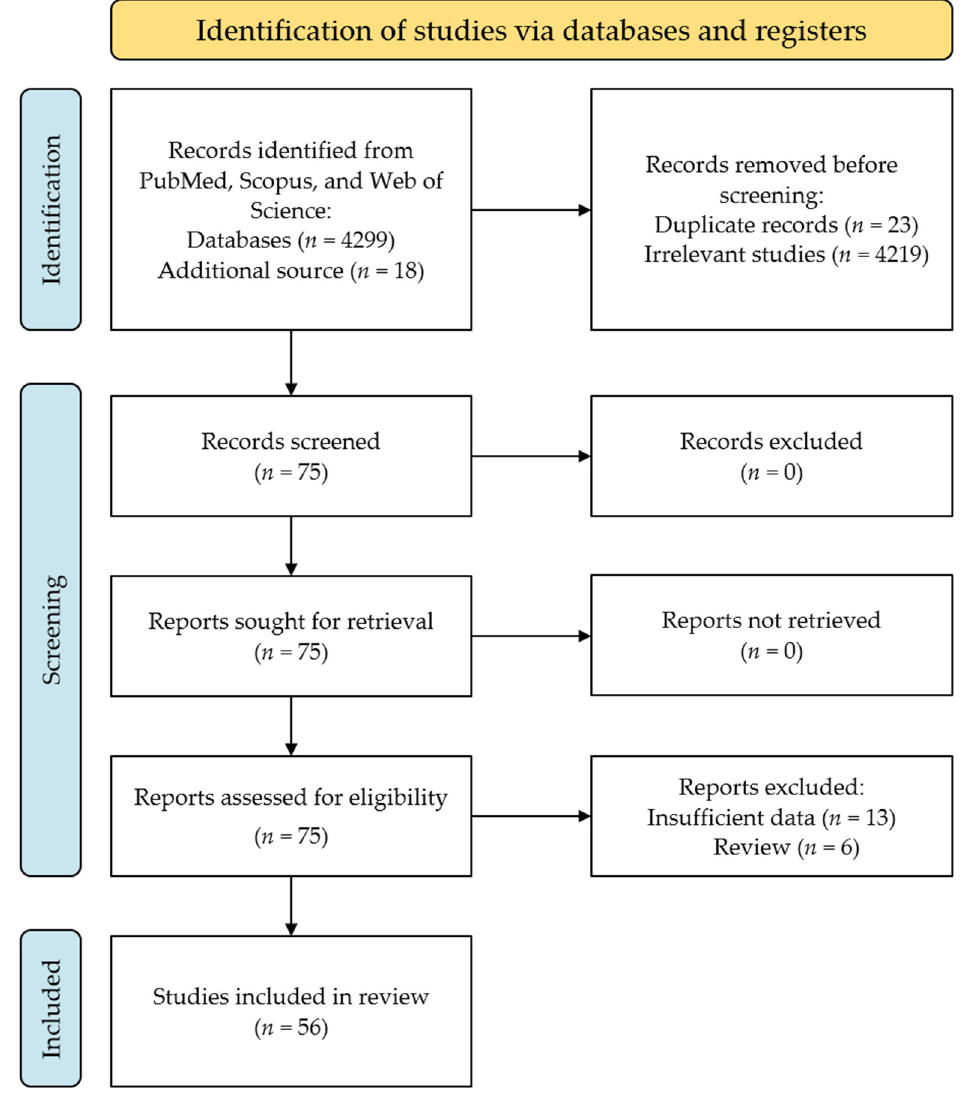
Figure 1. A flowchart of article selection in this review. Table 1. Baseline characteristics of articles included in our analysis